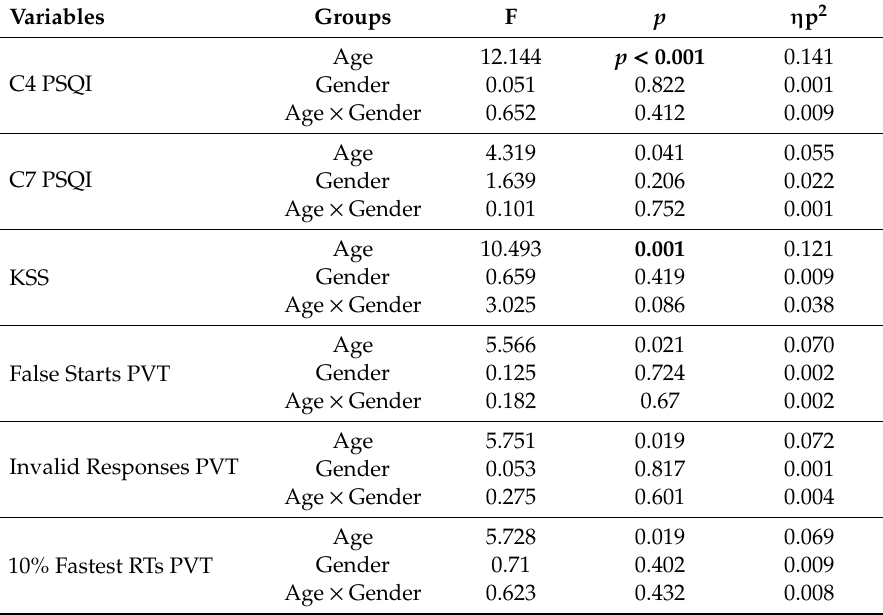
Table 1. Results of 2 × 2 between-subjects Age × Gender ANOVAs on sleep quality (PSQI), sleepiness (KSS), and vigilance (PVT) measures. The table shows Fisher coe ffi cients (F), the associated probability ( p < 0.0018), and the e ff ect size (partial eta-squared, η p 2 ).